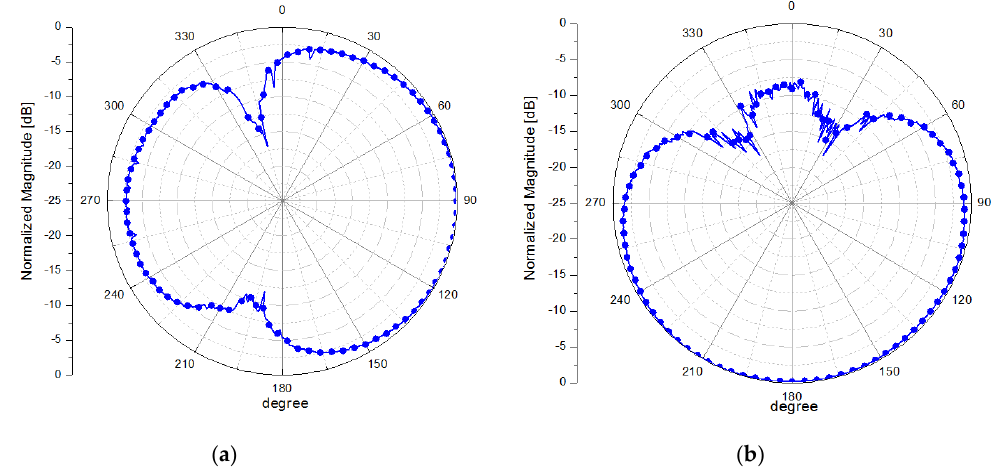
Figure 8. Measured E-plane radiation patterns of fabricated antenna when ( a ) first antenna is on and ( b ) second antenna is on.